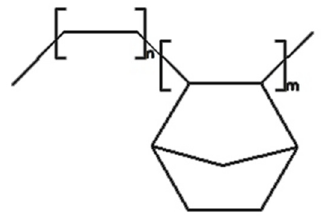
Figure 1. Ethylene–norbornene copolymer structure.